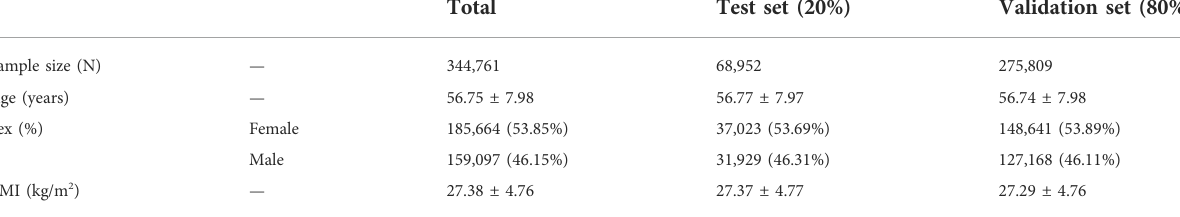
TABLE 1 Characteristics of the UK Biobank